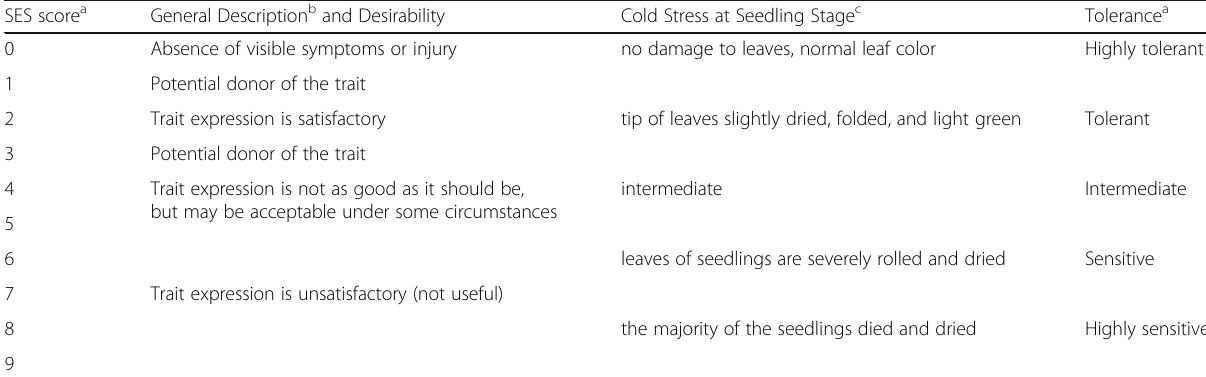
Table 1 Generalized Standard Evaluation System for rice